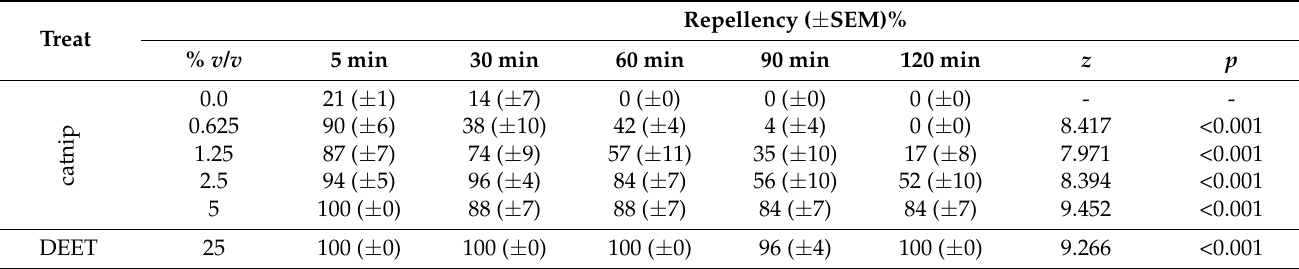
Table A1. Mean percentage ( ± SEM) of ticks repelled by catnip essential oil at different concentrations and by DEET (25% v / v ) in horizontal filter paper bioassays at different time points. n = 25 per concentration.